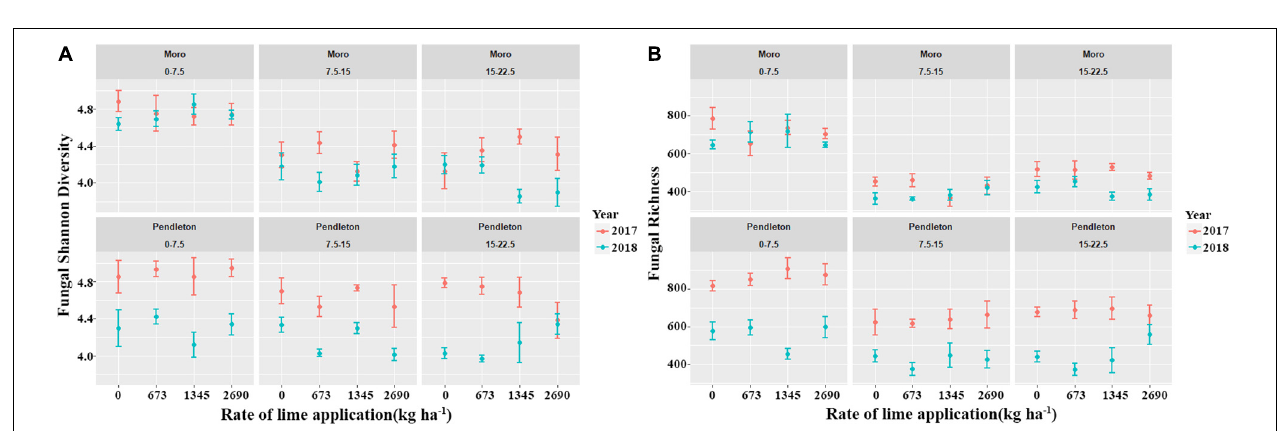
FIGURE 1 | Fungal: bacterial abundance ratios from soil at two wheat locations. (A) Pendleton. (B) Moro. F:B ratio: fungal: bacterial abundance ratio; Soil depth: 0–7.5 cm, 7.5–15 cm, and 15–22.5 cm; rate of lime application: 0, 673, 1,345, and 2,690 kg ha − 1 ; The values are means ( n = 8) ± SE ( p ≤ 0.05, Kruskal-Wallis test).